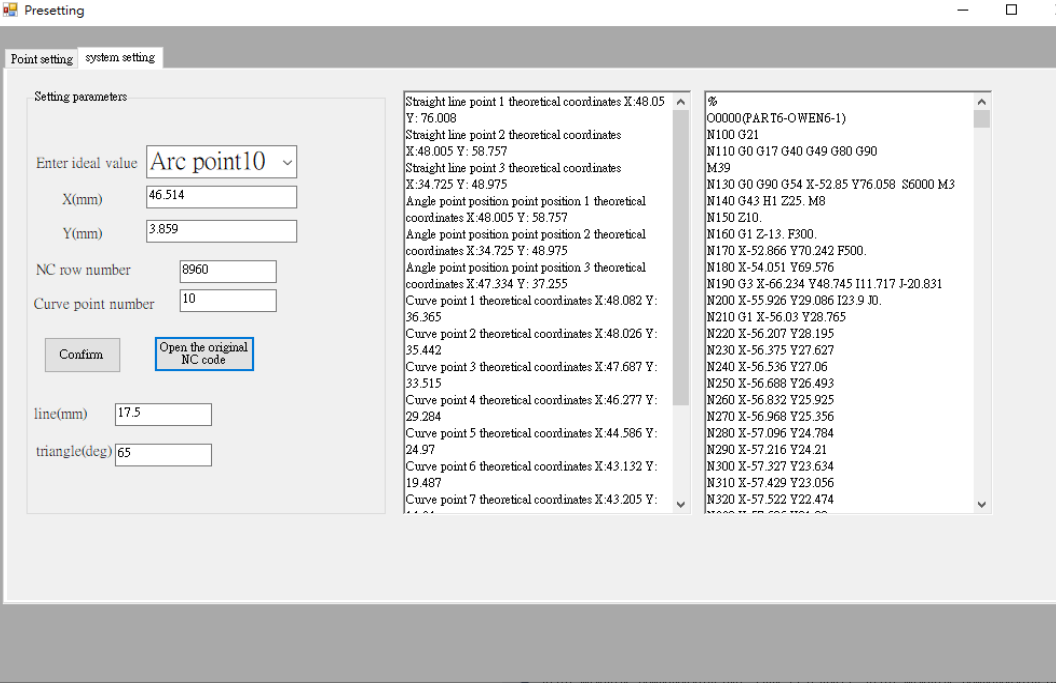
Figure 8. HMI—System setup interface.